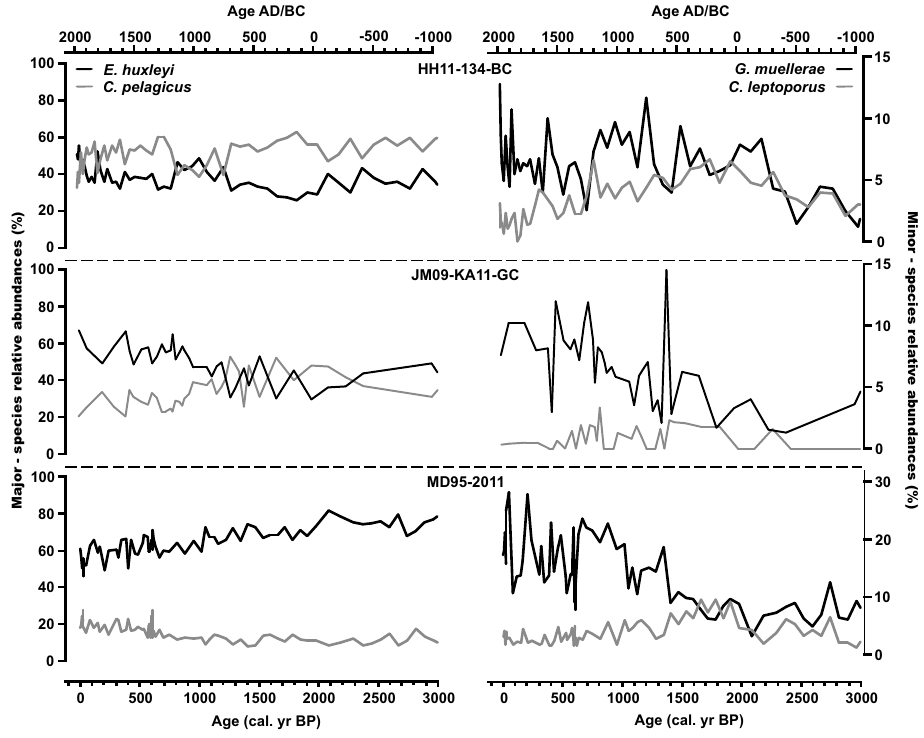
Fig. 4. Relative abundances (%) of major (left axes) and minor (right axes) coccolith species throughout the three studied